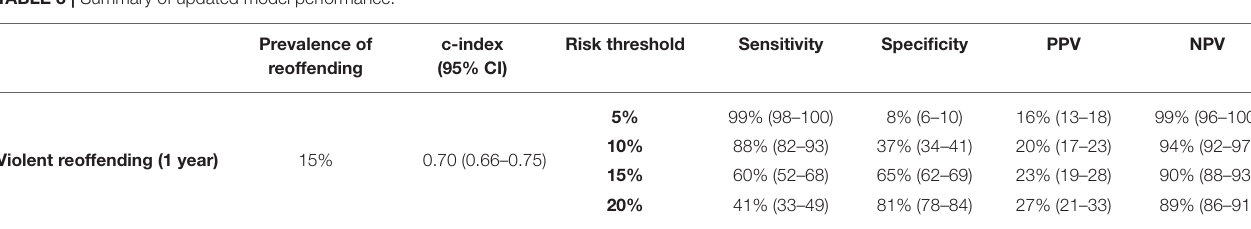
TABLE 3 | Summary of updated model